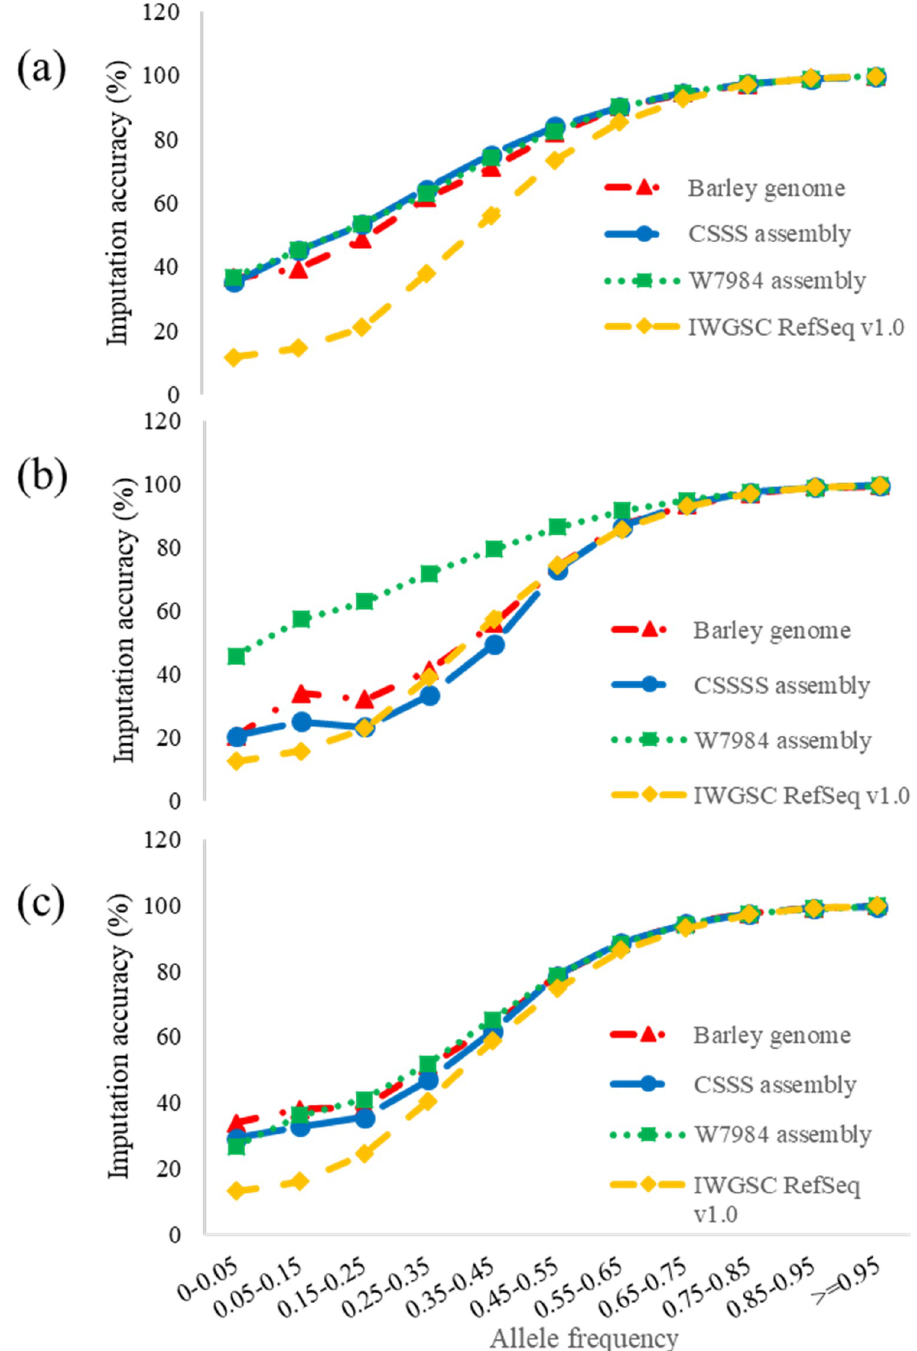
Fig 3. Relationship between imputation accuracy and allele frequency for (a) five, (b) six, (c) seven runs imputed with eight runs using barley genome, Chinese Spring survey sequence (CSSS), W7984 and IWGSC RefSeq 1.0 in Iranian wheat GBS